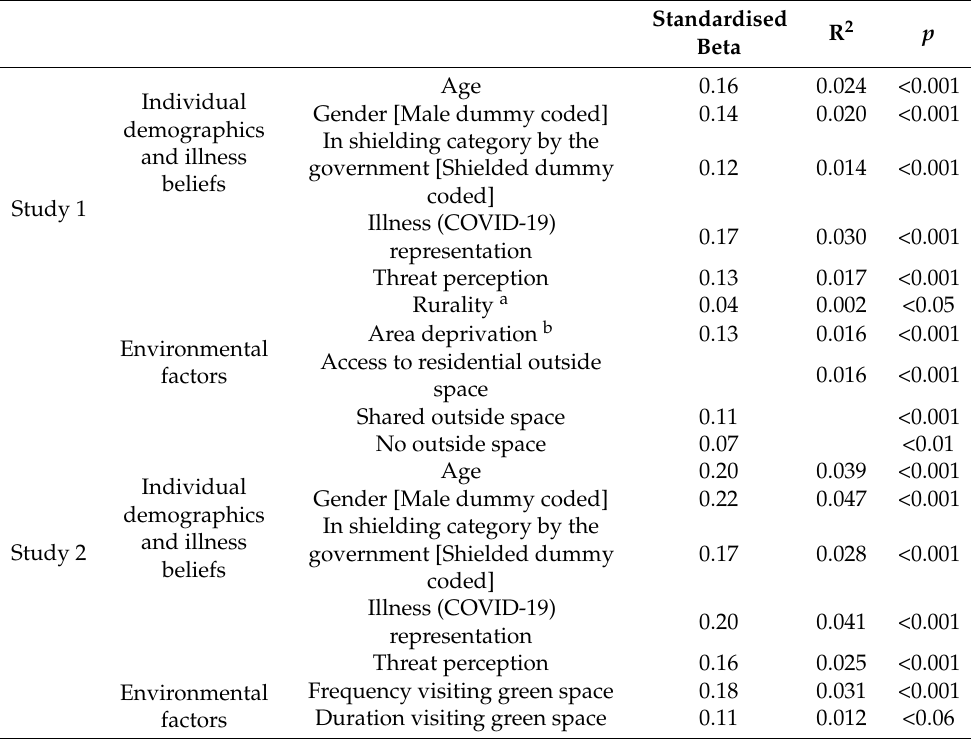
Table 2. Linear regression effects of individual demographics and illness beliefs and environmental factors on psychological